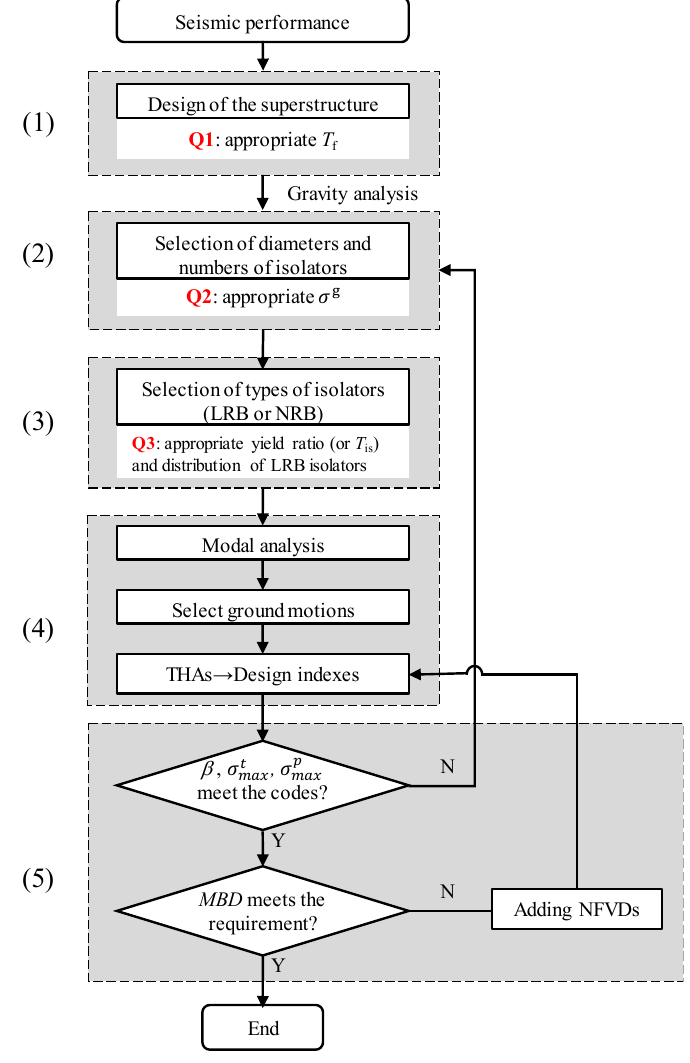
Figure 8. Traditional design method for seismically isolated tall building. (Q1~Q3 denote the critical problems).